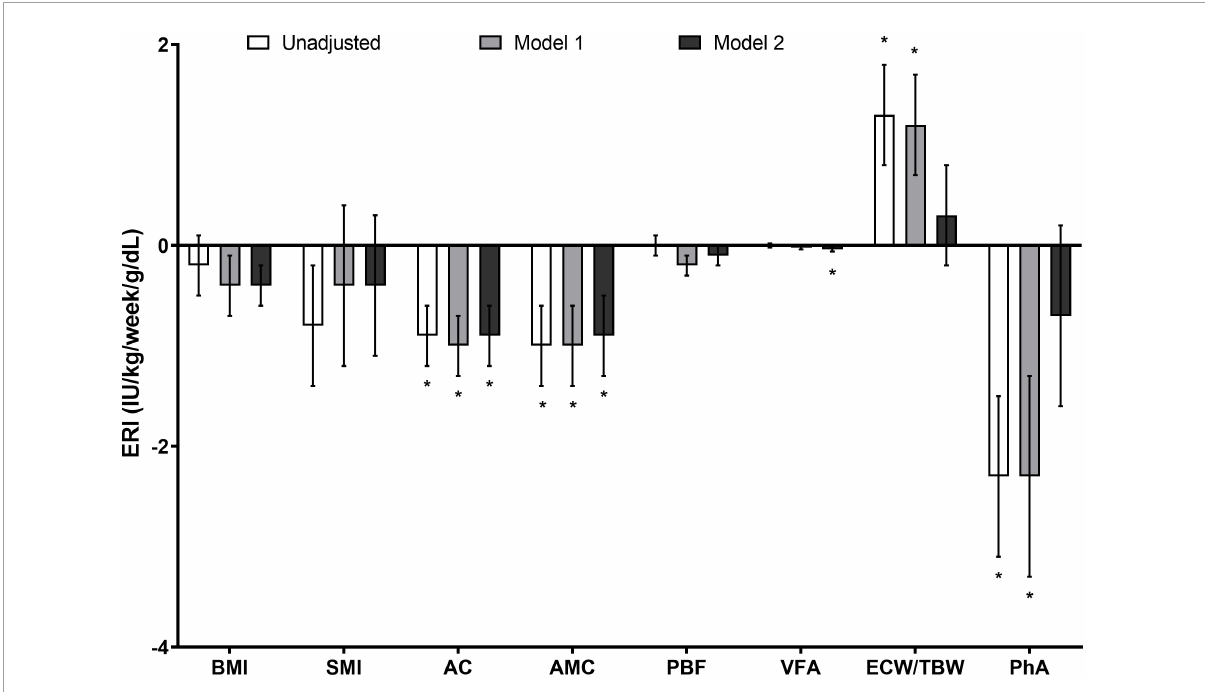
FIGURE1 Association between the ERI and parameters of body composition in patients receiving chronic hemodialysis. The ERI was negatively associated with BMI, AC, AMC, PBF, and VFA, and the associations persisted even after the adjustment for clinical and laboratory variables ( P = 0.070, 0.001, 0.010, 0.071, and 0.034, respectively). However, the correlation of ERI with ECW/TBW and PhA disappeared in the multivariate analysis. Data are expressed as estimate ± standard error (IU/kg/week/g/dl). * P < 0.05. Model 1 was adjusted for age, sex, and modified Charlson comorbidity index, while Model 2 was adjusted for the variables in Model 1 plus hemoglobin, transferrin saturation, albumin, hs-CRP, total cholesterol, and intact PTH levels. AC, arm circumference; AMC, arm muscle circumference; BMI, body mass index; ECW/TBW, the ratio of extracellular water to total body water; ERI, erythropoiesis-stimulating agent resistance index; hs-CRP, high-sensitivity C-reactive protein; PBF, percent body fat; PhA, phase angle; PTH, parathyroid hormone; VFA, visceral fat area.